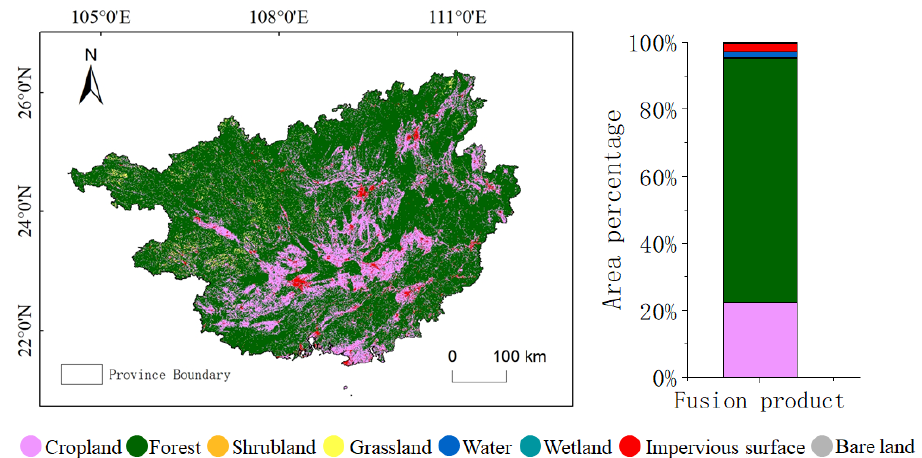
Figure 13. Map showing the spatial distribution of land cover types in Guangxi based on the six products.